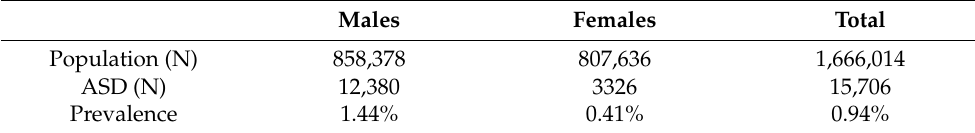
Table 1. Nationwide prevalence of ASD by gender for children aged 2–17 years in